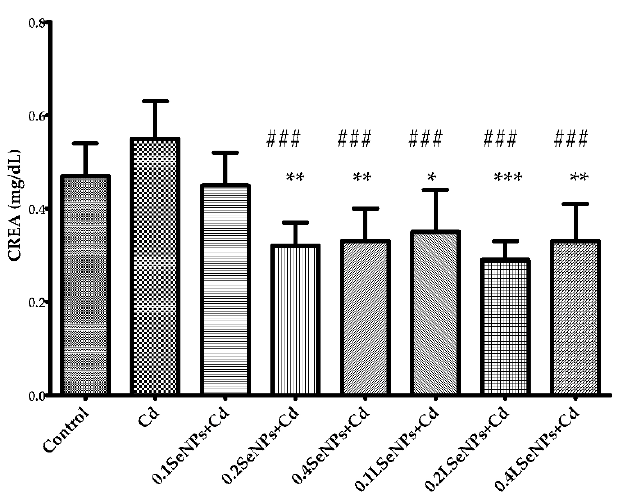
Figure 2. Effects of cadmium and both form of selenium (SeNPs, purified and LSeNPs) on CREA level and LDH activity after 30 days treatments. All values were expressed as mean ± SD for 10 mice in each group. Groups: Control-mice received only water; Cadmium group (Cd)-mice received orally 5 mg/kg CdCl 2 ; 0.1 SeNPs + Cd (0.1 mg/kg SeNPs + 5 mg/kg CdCl 2 ); 0.2 SeNPs + Cd (0.2 mg/kg SeNPs + 5 mg/kg CdCl 2 ); 0.4 SeNPs + Cd (0.4 mg/kg SeNPs + 5 mg/kg CdCl 2 ); 0.1 LSeNPs +